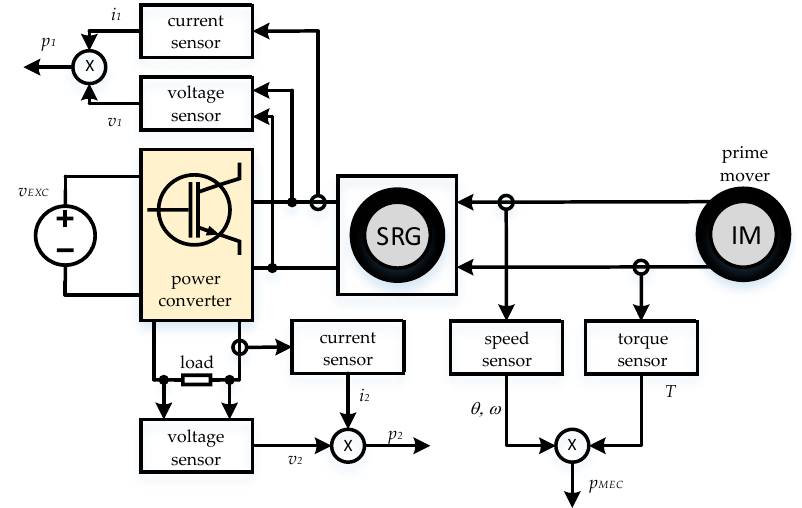
Figure 4. Block diagram of the computational